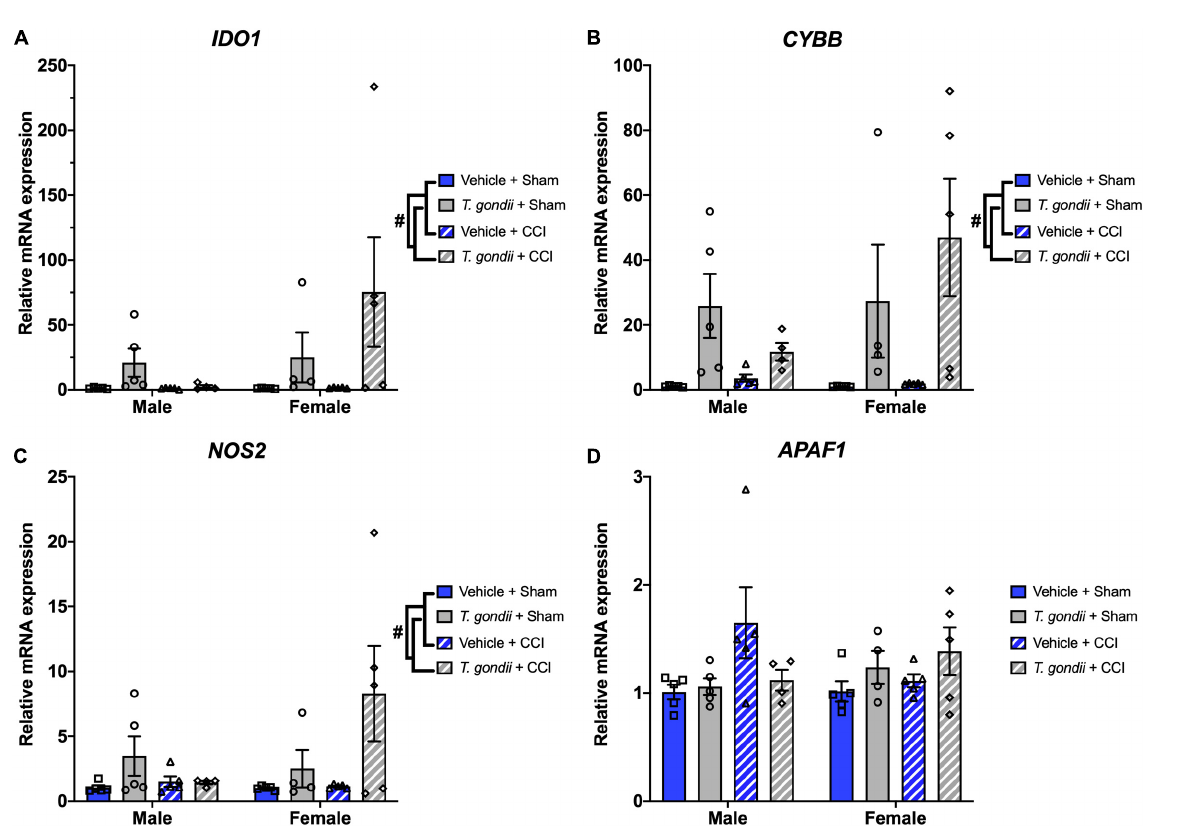
FIGURE7 Chronic Toxoplasma gondii infection increases gene expression of oxidative stress mediators. Gene expression of IDO1 (A) , CYBB (B) , and NOS2 (C) was increased in T. gondii -infected mice compared to vehicle mice. A sex by infection interaction was detected for the expression of APAF1 (D) , however, post-hoc analyses failed to reach significance. # T. gondii -infected mice significantly differ from vehicle mice, p < 0.05. n = 4–5/group/sex. Data shown is mean ±